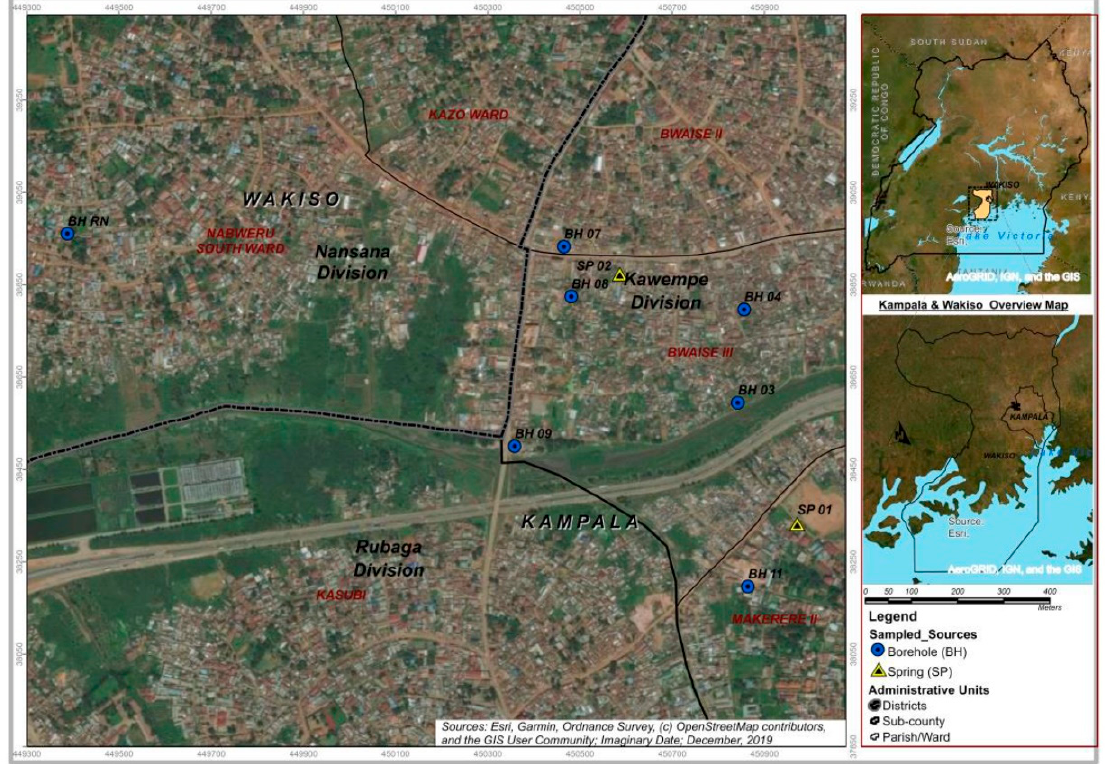
Figure 2. Location of the Bwaise informal settlement and location of the sampled sources.